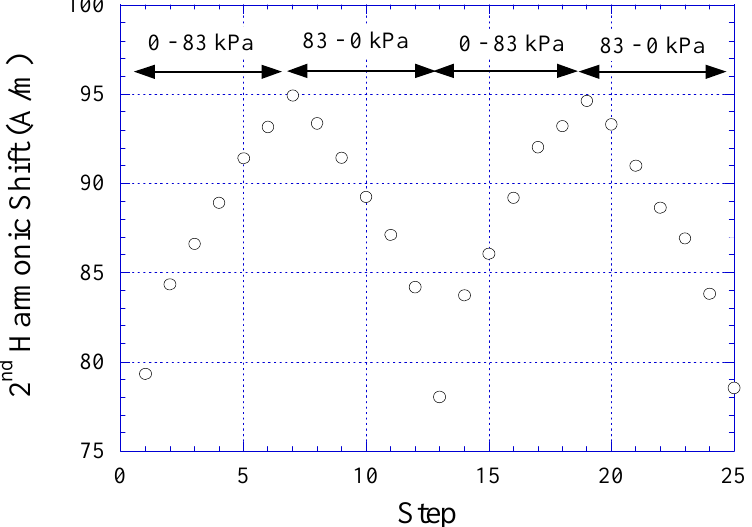
Figure 6. The response of the pressure sensor at increasing and decreasing pressure cycles showed the sensor was repeatable and had no